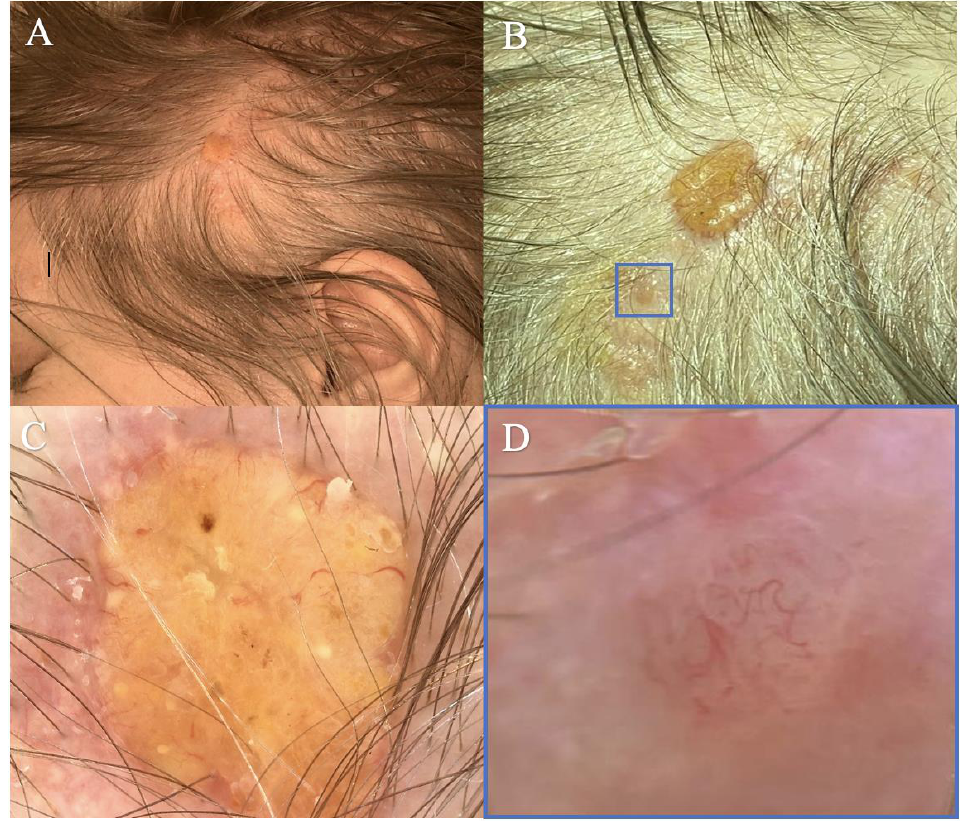
Figure 1. Clinical and dermoscopic aspects of the lesion. ( A ) A yellowish, verrucous lesion sur- rounded by a poorly defined, erythematous plaque on the scalp (temporoparietal area) of a 49 year-old female. ( B ) A close-up of the lesion from panel ( A ) (the dermoscopy of the main lesion is depicted in panel ( C ) and the dermoscopy of the lesion in the blue square is illustrated in panel ( D )). ( C ) Dermoscopy of the central lesion showing globules aggregated in clusters and fine peripheral linear, serpiginous, and arborizing vessels. The vessels do not cross the central region of the tumor. Multiple yellow dots are observed on the surface of the lesion. ( D ) Dermoscopy of a nodular lesion in the proximity of the central one reveals a pink, poorly defined nodular lesion with fine, arborizing vessels that cross the central surface of the lesion and fade towards the periphery.